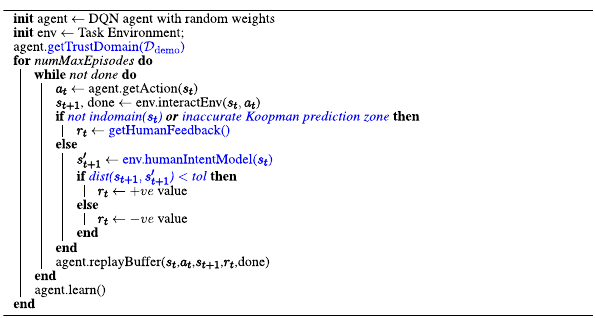
Algorithm 1. Koopman Operator – Based Knowledge- Guided